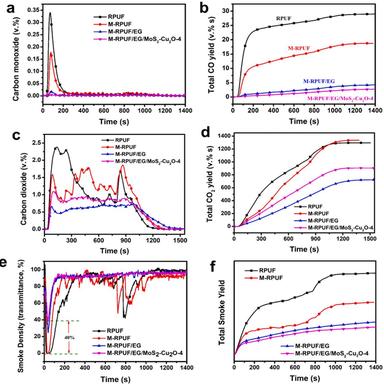
CO curves (a, b), CO2 curves (c, d), and total smoke density (e, f) of pristine RPUF and M-RPUF/EG/MoS2-Cu2O-4 composite obtained from SSTF tests.